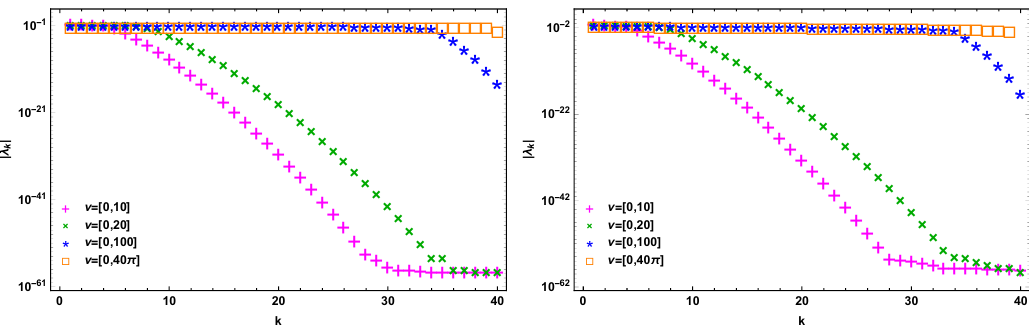
Figure 1 . Eigenvalues (cid:21) k of the Kernel matrix for the direct inversion method on the left and the derivative inversion method on the right calculated with di(cid:11)erent discretization intervals of (cid:23) . Note that only for the case corresponding to a genuine discrete Fourier transform, (cid:23) = [0 ; 40 (cid:25) ], do all the eigenvalues remain of the same order. All other ranges show exponentially suppressed